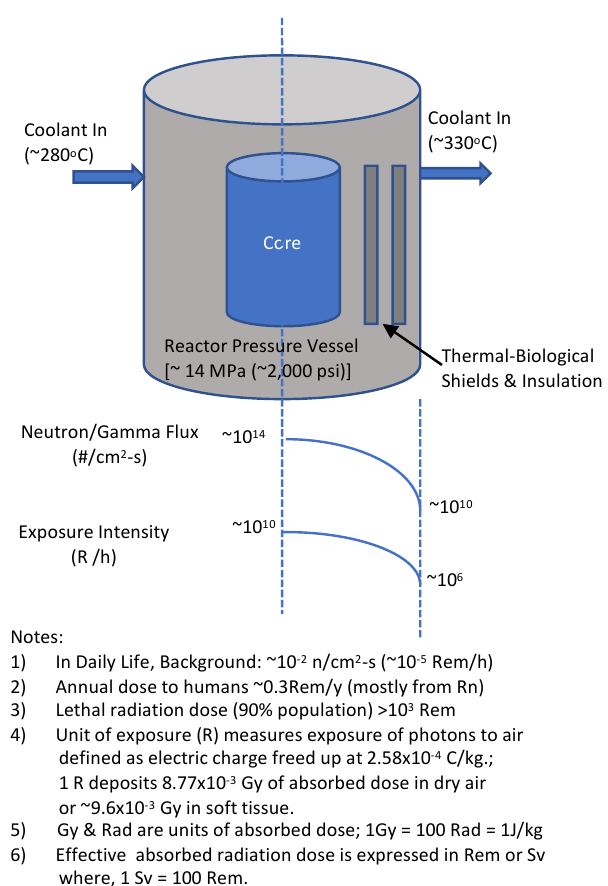
Figure 1. Illustration of extreme radiation conditions in a 3000 MWt nuclear reactor.